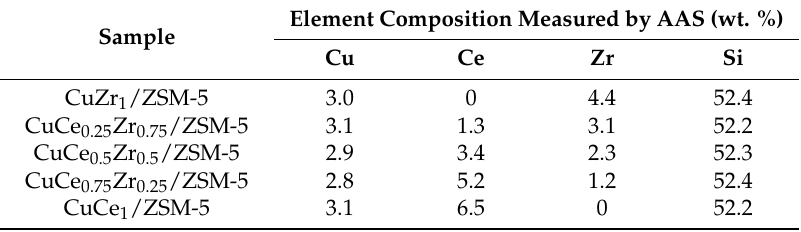
Table 3. Element compositions of all catalysts. Element Composition Measured by AAS (wt. Sample